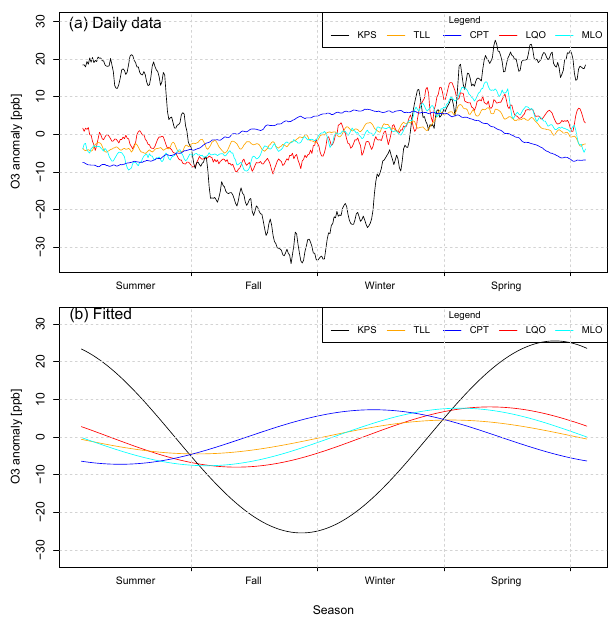
Figure 5. (a) Mean annual cycle of ozone anomalies at different background stations showing a spring maximum (El Tololo, TLL; La Quiaca, LQO; Mauna Loa, MLO), a summer maximum (K- puszta, KPS), or a summer minimum (Cape Point, CPT). Anoma- lies are deviations from the annual mean. The x axis shows the sea- son of the year. Northern hemispheric data are shifted by 182